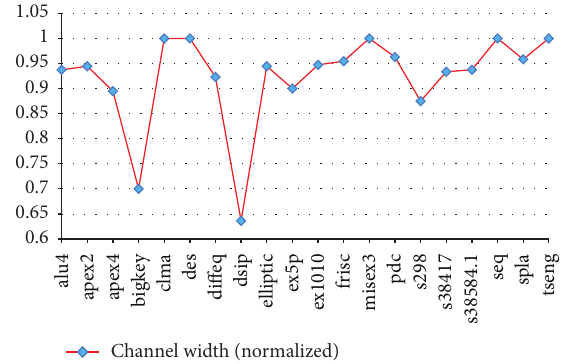
Figure 7: Comparative results of channel width for diffusion based placement algorithm using 1-sigma approach normalized to the respective results from VPRs placement algorithm for cluster size 𝑁 = 4